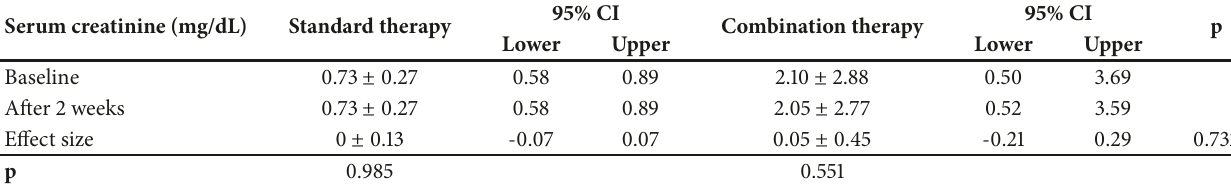
Table 4: Serum creatinine levels between